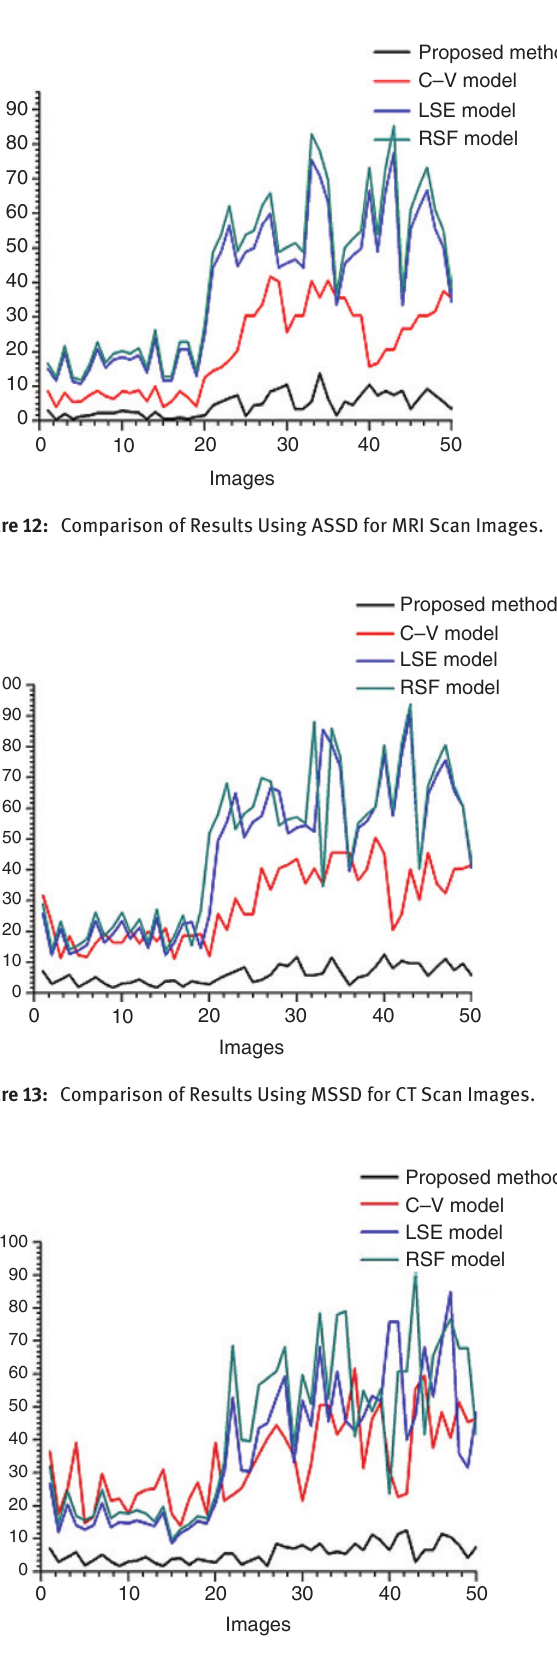
Figure 14: Comparison of Results Using MSSD for MRI Scan